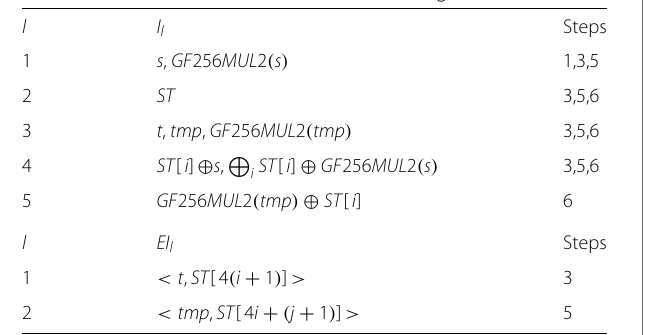
Table 1 Intermediate and extra variables of Algorithm 3